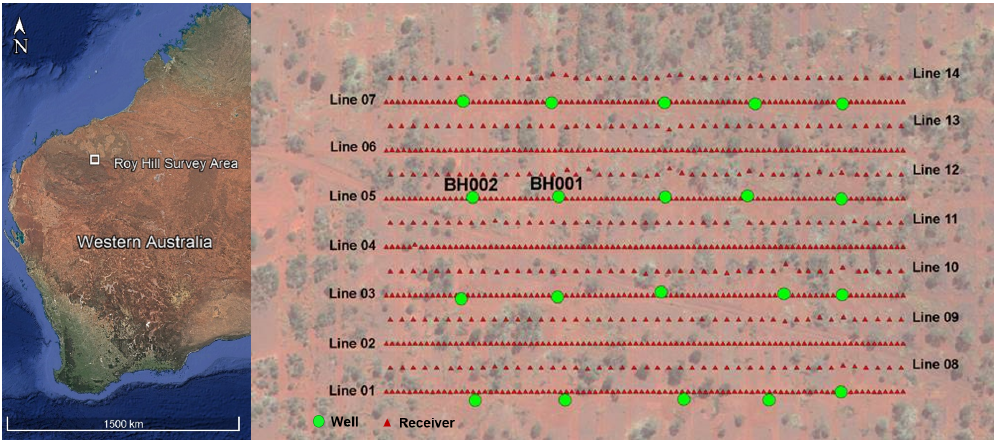
Table 1. A summary of seismic survey acquisition parameters at Roy Hill. Dashes indicate that no drilling mechanism was used. Acquisition parameters Lines 1–7 Lines 8–14 Drilling mechanism Reverse circulation – Recording system Sercel’s Unite nodes, eX-3 Sercel’s Unite nodes, eX-3 Receiver line spacing (m) 12.5 12.5 Receiver spacing (m) 3 6 Recording sample interval (ms) 2 2 No. of nodes 96 49 Recording component Vertical Vertical Seismic weight drop source Hurricane force 9 (720kg) Hurricane force 9